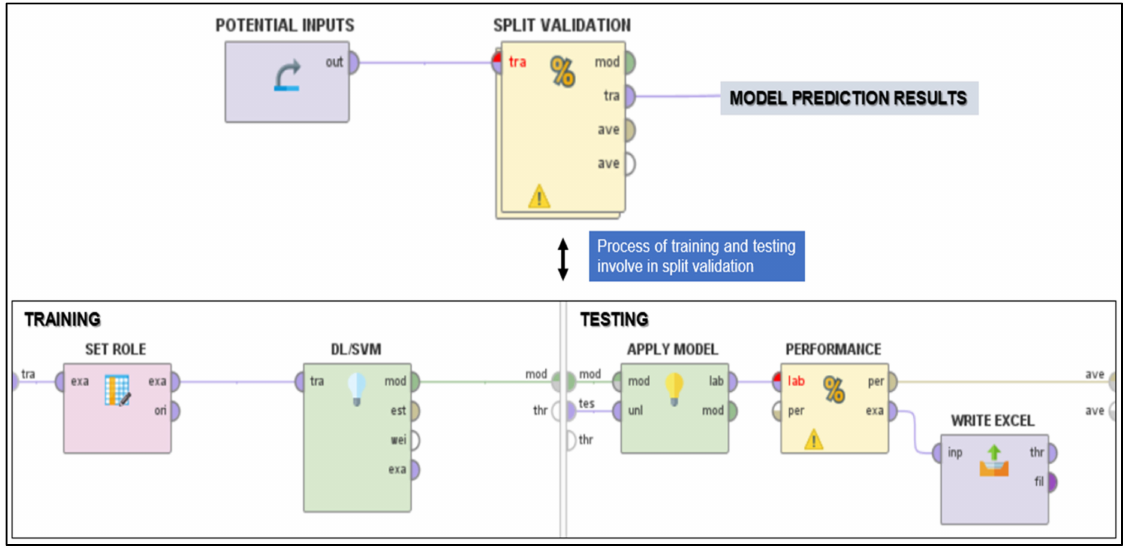
Figure 9. The framework model applied for all four prediction models from Rapidminer machine learning.